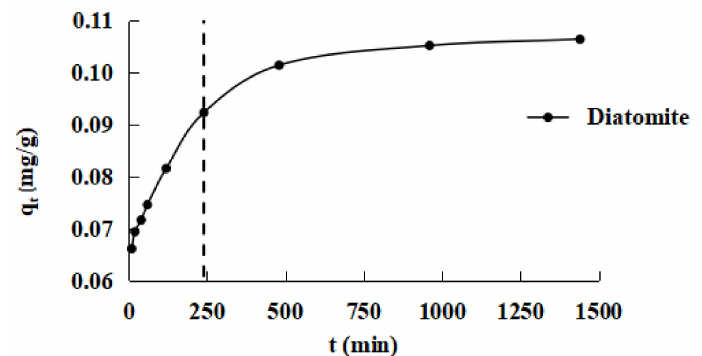
Figure 6. Adsorption kinetics of phosphorus on diatomite.